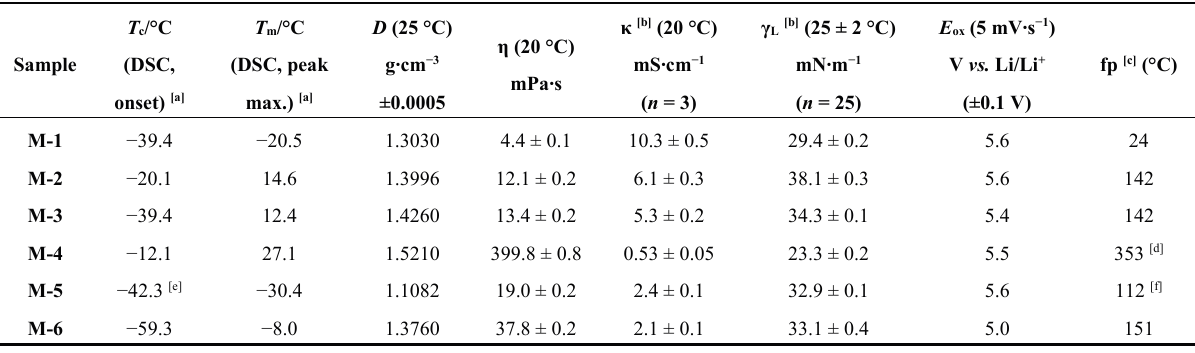
Table 2. Physical properties of electrolyte mixtures: T c , crystallizing temperature; T m , melting point; fp, flash point; d , density; η , viscosity; κ , conductivity, E ox , electrochemical oxidative stability (against Pt); and γ L , surface tension